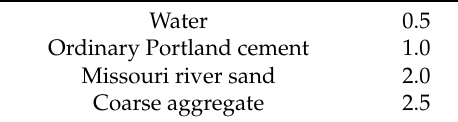
Table 3. Concrete mixture proportion.